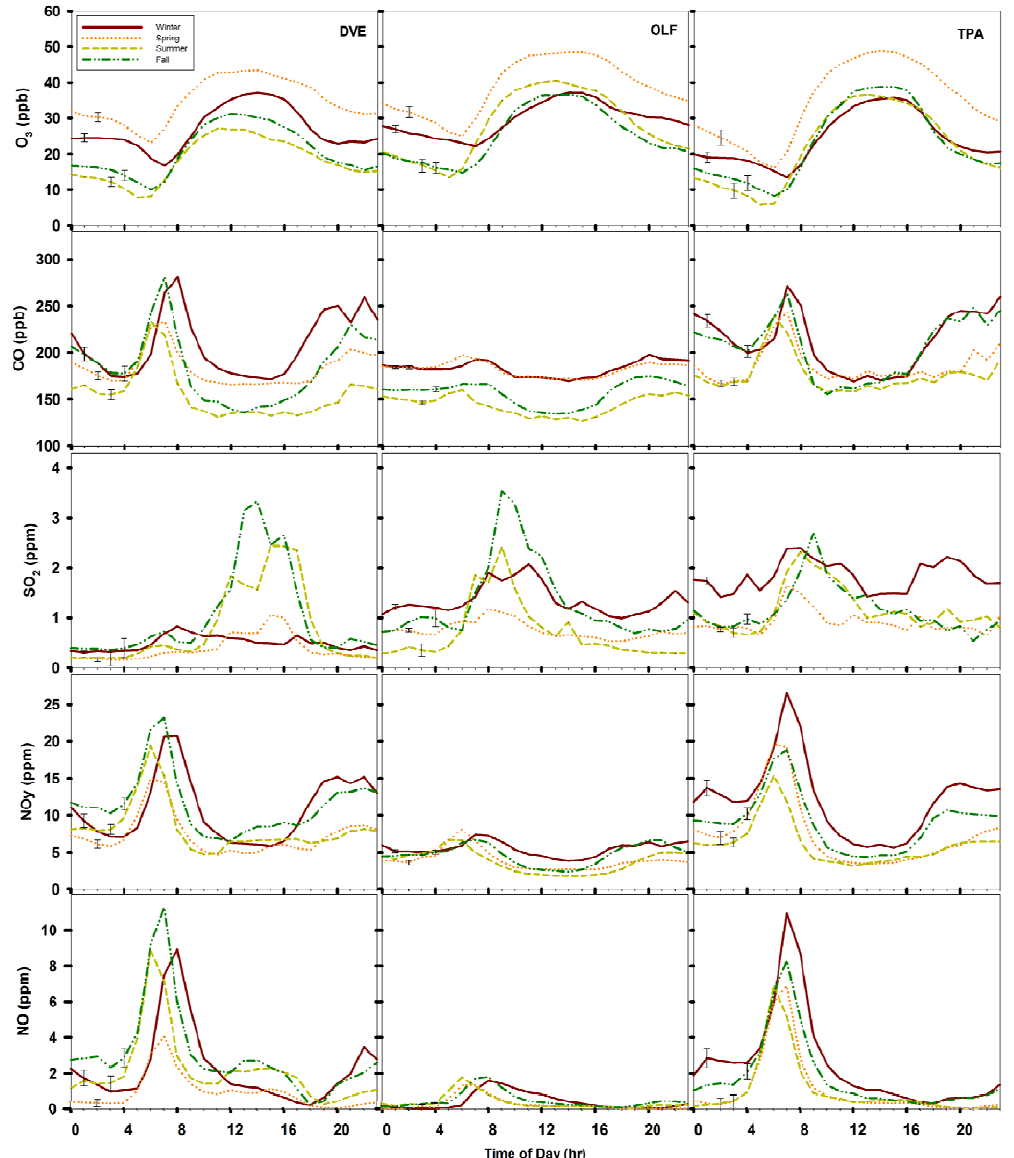
Fig. 3a. Diel bin plots of ozone (O 3 ), carbon monoxide (CO), sulfur dioxide (SO 2 ), and nitrogen oxides (NO y and NO) developed using 2-h seasonal means. Error bars represent the standard error associated with the two hour data with the first error bar representing winter values, second bar being spring, the third bar is summer and fourth bar is fall. Panels show data for DVE, OLF and TPA from left to